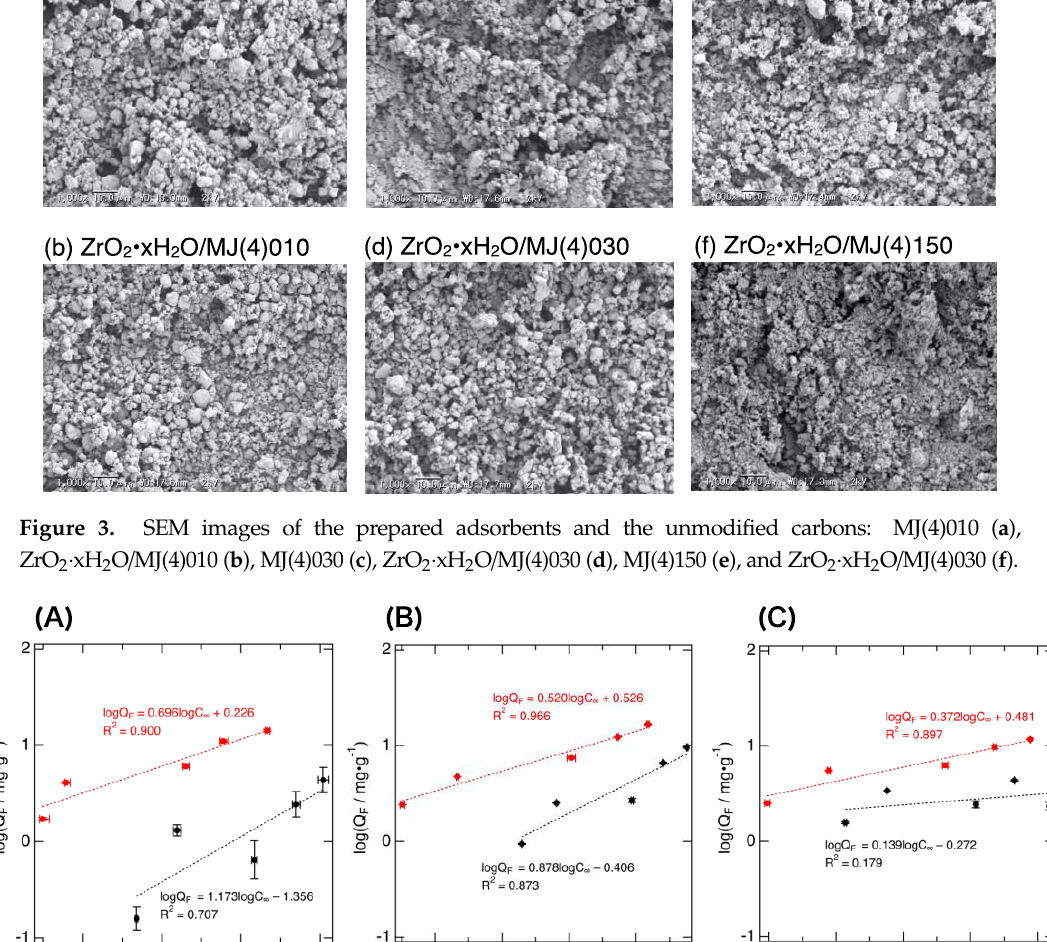
Figure 3. SEM images of the prepared adsorbents and the unmodified carbons: MJ(4)010 ( a ), ZrO 2 ·xH 2 O/MJ(4)010 ( b ), MJ(4)030 ( c ), ZrO 2 ·xH 2 O/MJ(4)030 ( d ), MJ(4)150( e ), and ZrO 2 ·xH 2 O/MJ(4)030 ( f ).